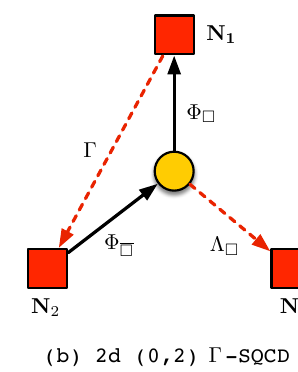
= (0 ; 2) (a) SQCD and (b) (cid:0) N